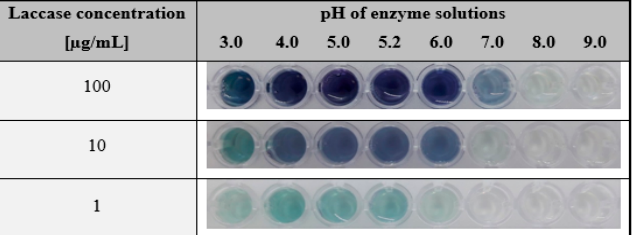
( b ) Figure 6. Evaluation of storage stability for ABTS—a substrate used for determination of laccase activity in a gelatine hydrogel-based colourimetric test. ABTS was tested in its native form in a phos- phate-citrate buffer solution at pH 5.2 ( a ), and as immobilised in a hydrogel matrix after 0–20 days ( b ). Storage stability of gelatine hydrogel test with immobilised ABTS was performed after 30 days. Laccase detection assays were compared after 30 min of colourimetric test applying enzyme con- centration of 100 µg/mL. Experimental conditions: 4 °C, and with 1.5 mg/mL of ABTS. When considering the storage stability of the entire system tested, a similar proce- dure was applied. The gelatine matrices containing ABTS were left in closed well plates at 4 °C for 30 days. During this time, the determination of storage stability was performed for the hydrogel matrix at days 10 and 30 and for the matrix at the start of the test (control). The results of the colourimetric response of the test for time t = 0 min and after 30 min for